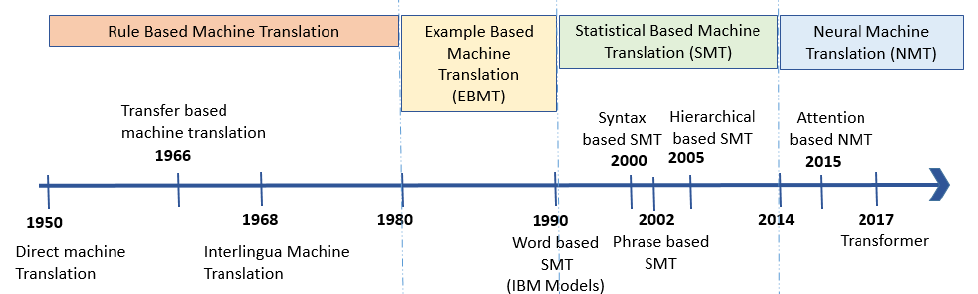
Figure 1. The evolution of machine translation systems over the years.